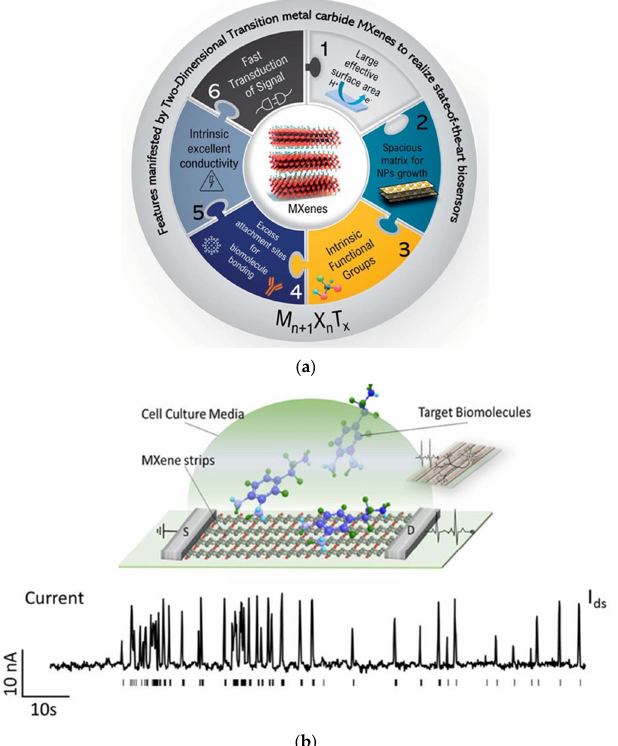
Figure 5. ( a ) Schematic representation of the main features of MXenes with regard to their applica- tion in biosensors. (Reprinted with permission [149]. This journal is © The Royal Society of Chem- istry 2022.) ( b ) Mechanisms of the SPR biosensors based on SMQDs groups. (Reprinted with permission [150]. Copyright © 2020, Author(s). Published by IOP Publishing Ltd.)